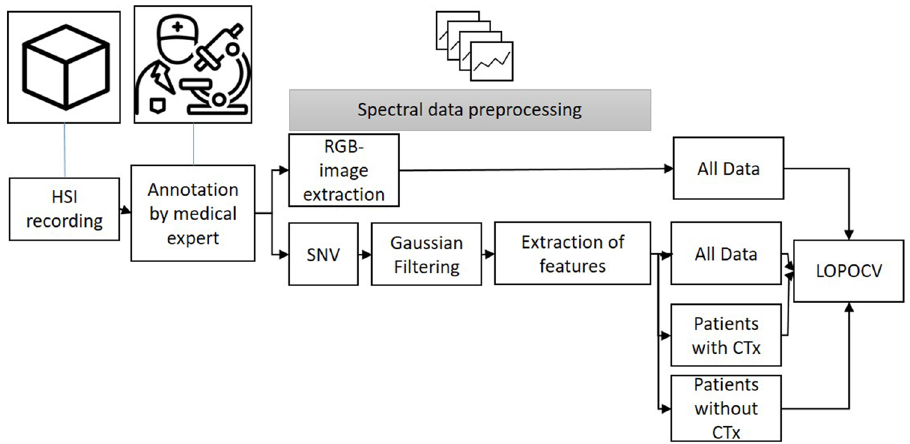
Figure 10. Schematic description of the data preprocessing (HSI- hyperspectral imaging, SNV- standard normal variate, RGB- Red Green Blue, CTx- neoadjuvant chemotherapy, LOPOCV- leave-one-patient-out